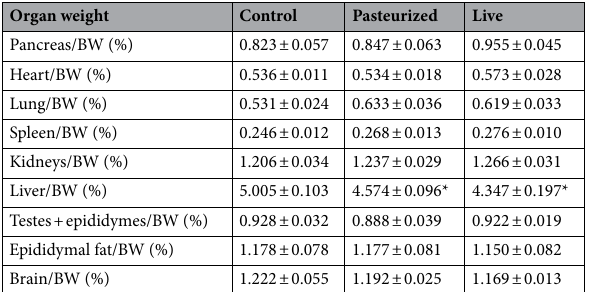
Table 2. Relative organ weights after oral administration of P. copri for 29 days. Values are presented as mean ± SEM of 10 replicates. BW body weight. *Mean values were significantly different from the control group (p-value < 0.05).